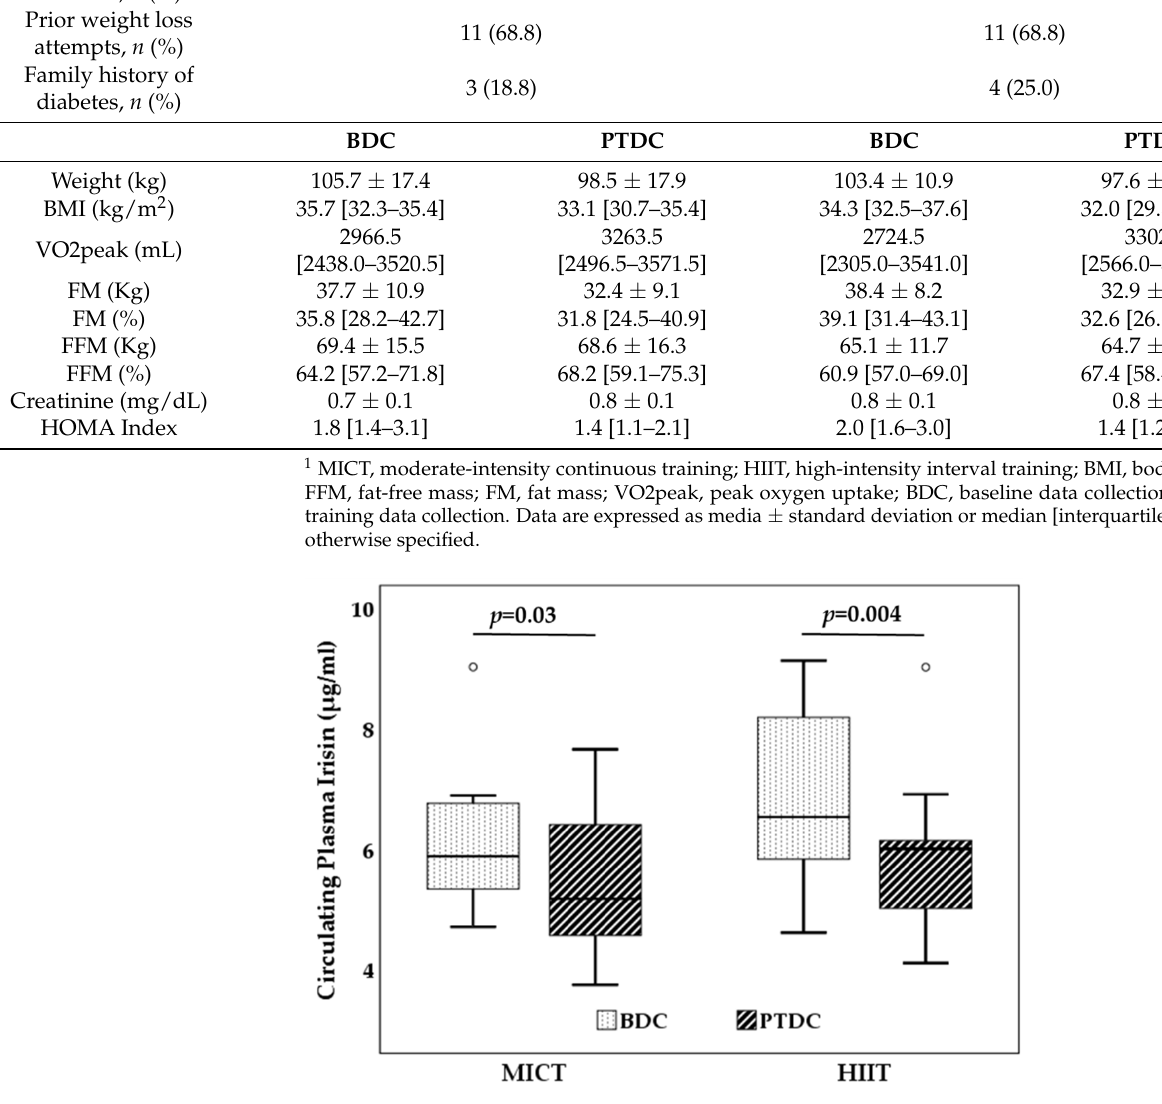
higher post-exercise irisin levels than males (6.32 [5.51–6.75] vs. 4.97 [4.57–5.72] µ g/mL, p = 0.001) (Figure